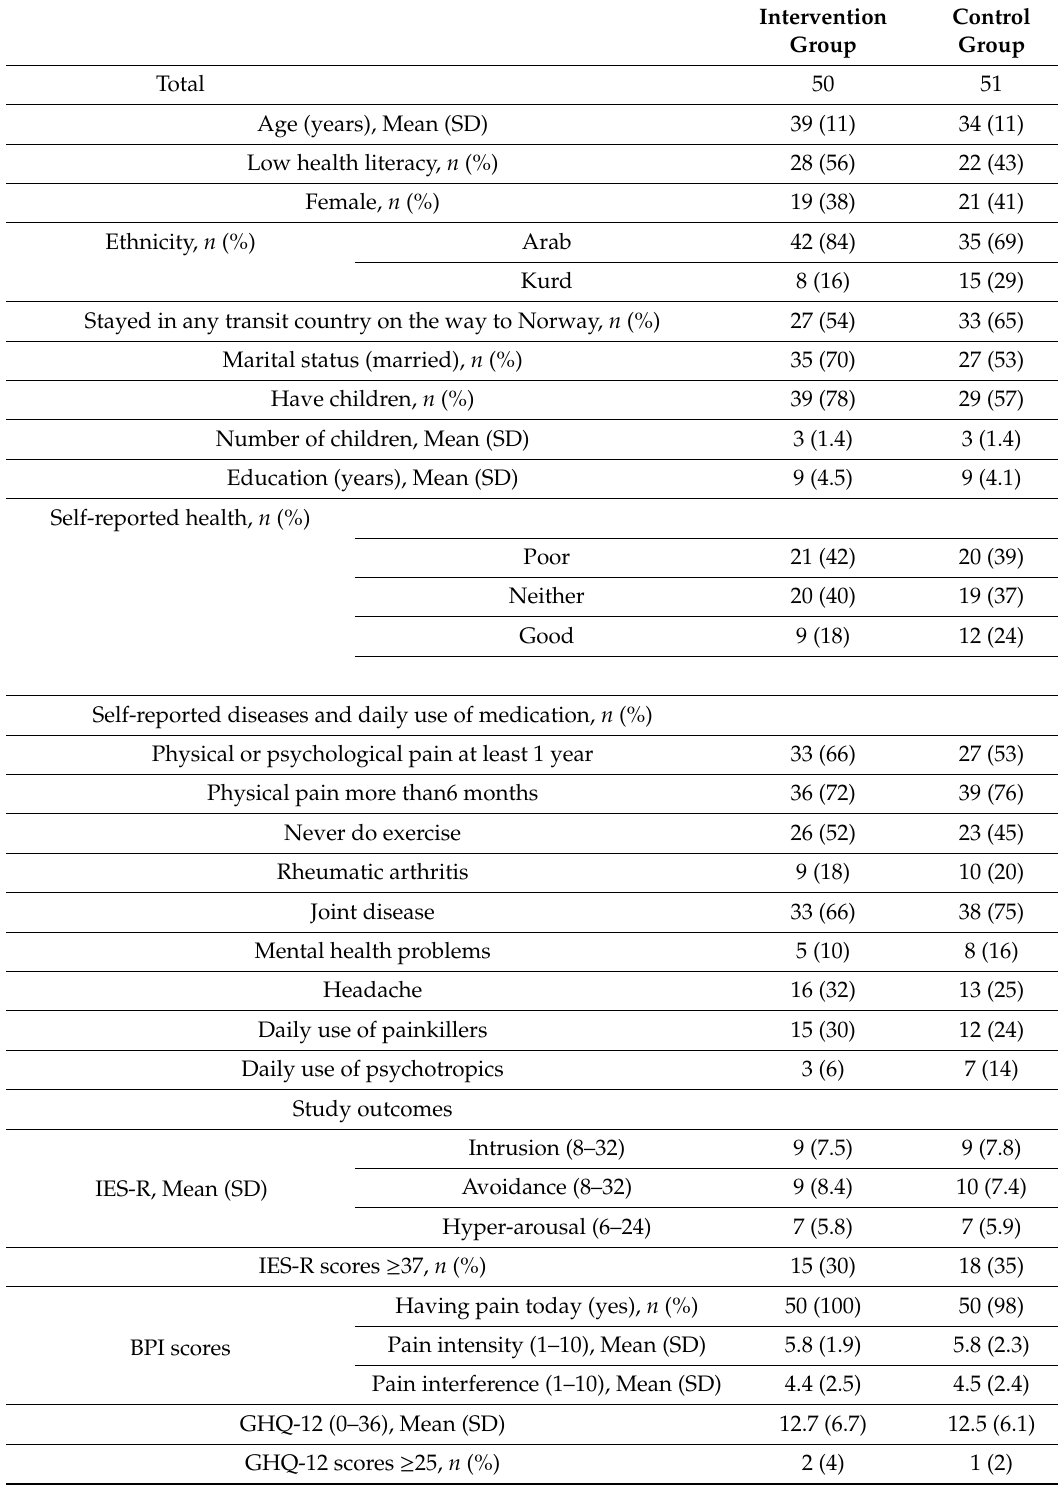
Table 1. Characteristics of the intervention and control groups at baseline.